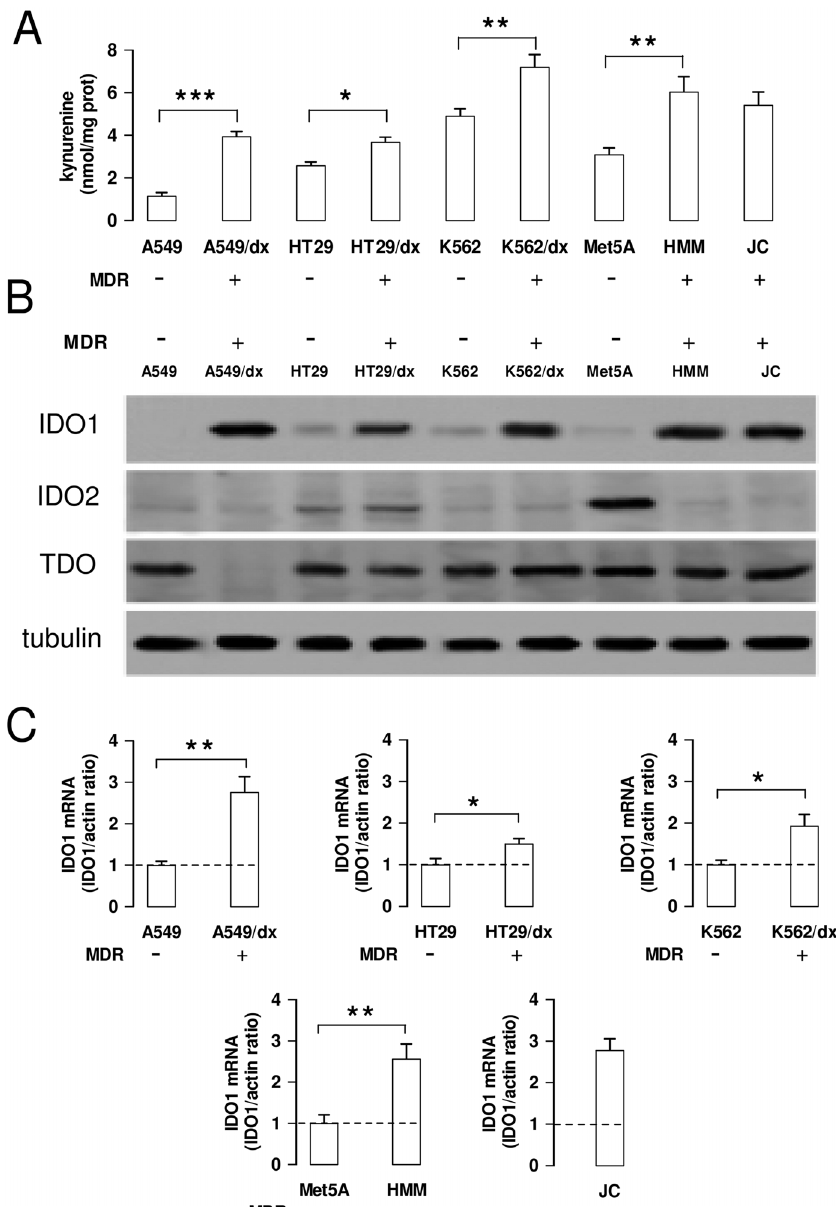
Fig 1. Kynurenine production and IDO1 expression in chemosensitive and multidrug resistant cells. Human chemosensitive lung cancer A549 cells and chemoresistant A549/dx cells, human chemosensitive colon cancer HT29 cells and chemoresistant HT29/dx cells, human chemosensitive chronic myelogenous leukemia K562 cells and chemoresistant K562/dx cells, human chemosensitive mesothelial Met5A cells and human chemoresistant malignant mesothelioma HMM cells, murine chemoresistant mammary JC cells were subjected to the following investigations. A . The kynurenine levels in the cell culture supernatants were measured spectrophotometrically. Data are presented as means ± SD (n = 4). * p < 0.05, ** p < 0.01, *** p < 0.001: chemoresistant cells (MDR-positive) versus the corresponding chemosensitive (MDR-negative) cells. B . Western blot analysis of IDO1, IDO2 and TDO expression. The β -tubulin expression was used as control of equal protein loading. The figure is representative of 3 experiments with similar results. C . The expression level of IDO1 mRNA was measured by qRT-PCR. Data are presented as means ± SD (n = 4). * p < 0.01, ** p < 0.002: chemoresistant cells (MDR-positive) versus the corresponding chemosensitive (MDR- negative) cells.